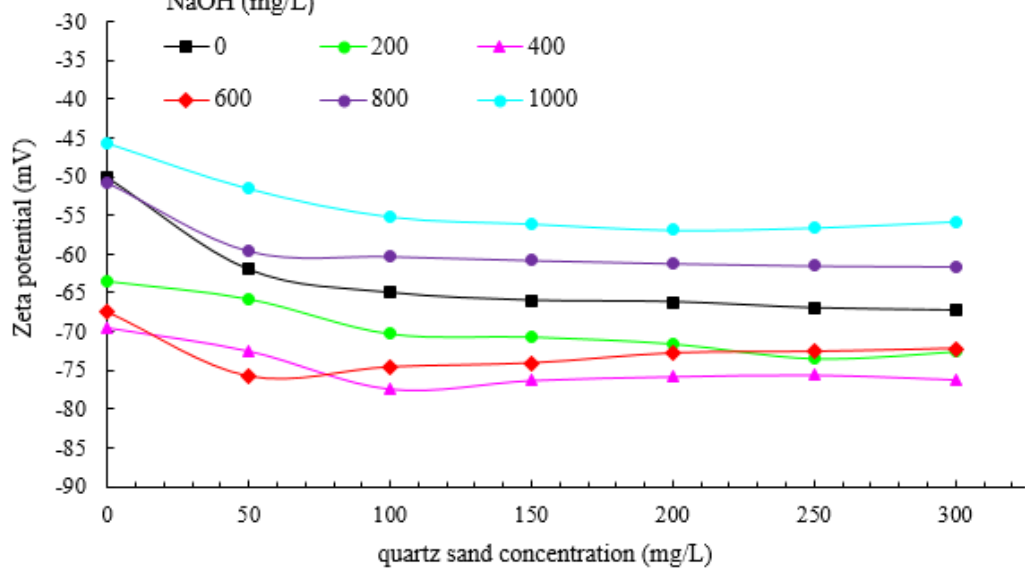
Figure 6. The synergetic effect of alkali and quartz sand particles on Zeta potential (polymer concentration 500 mg/L, surfactant concentration 200 mg/L).